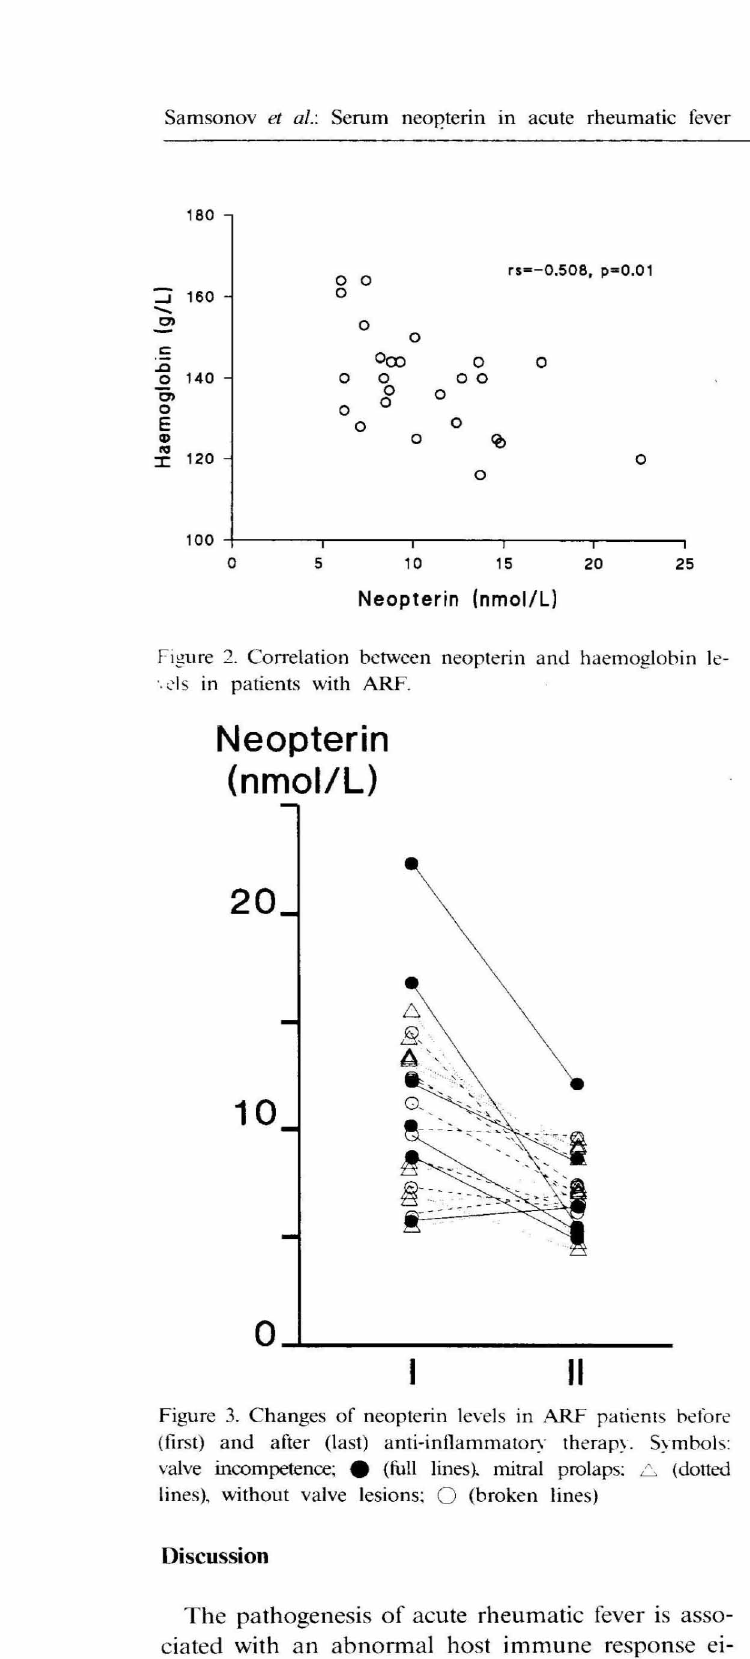
Figure 3. Changes of neopterin levels in ARF patients before (first) and after (last) anti-inflammatory therapy. Symbols: valve incompetence; • (full lines~ mitral prolaps: ~ (dotted lines), without valve lesions; 0 (broken